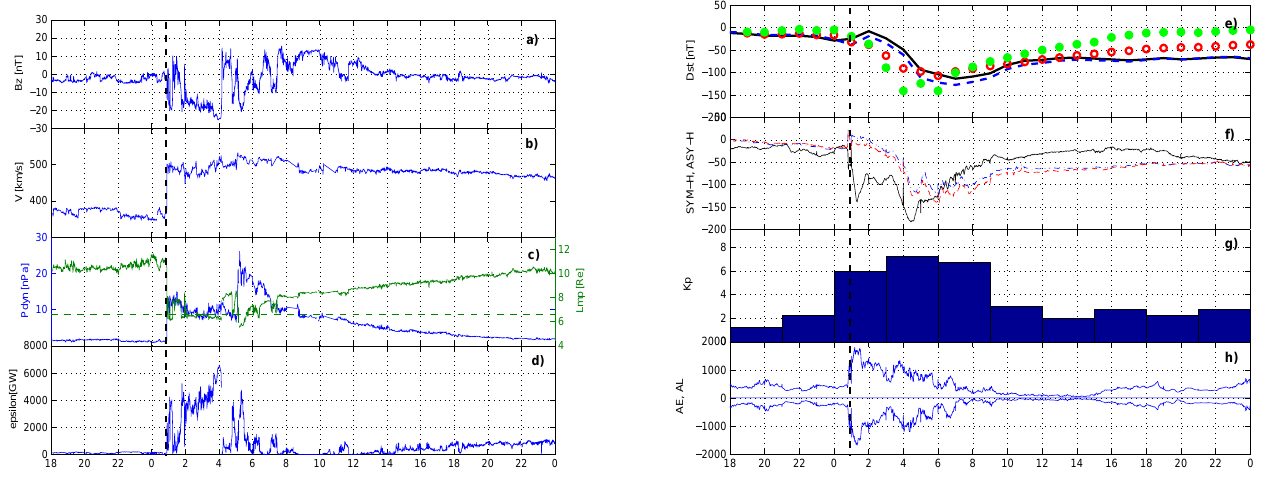
Fig. 3. Solar wind parameters and geomagnetic indices for a 30-h interval from 17 April, 18:00 UT–18 April, 24:00 UT, 2001 measured by ACE. The panels from top to bottom are the same as in Fig. 2. The dashed line indicates the